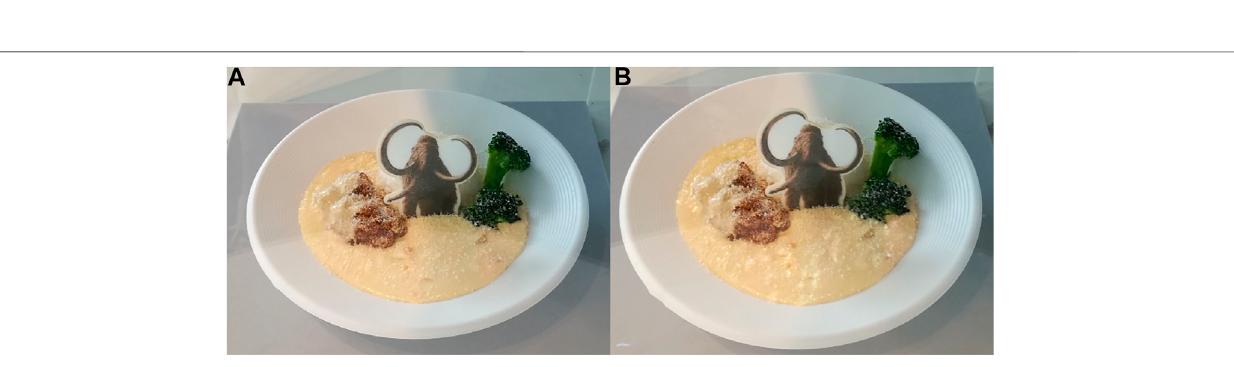
FIGURE 11 | (A) Curry with the single color projected and (B) with the boiling effect